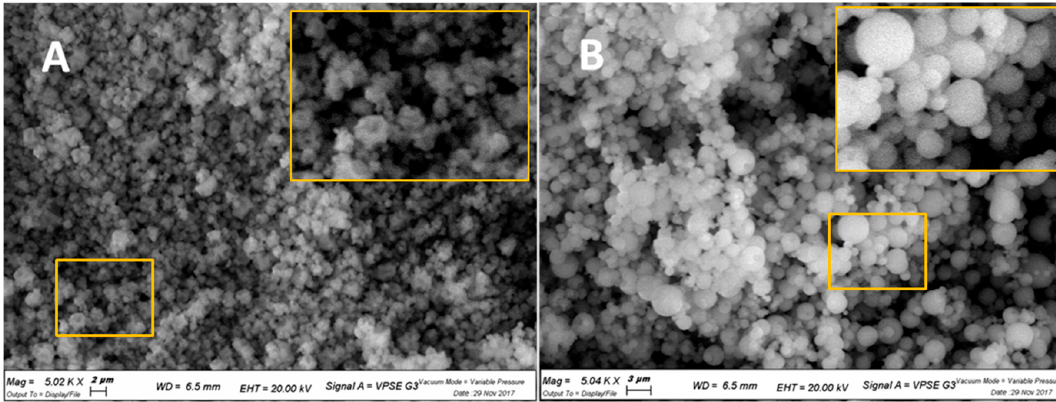
Figure 2. SEM micrographs with magnifications of 5000 times of: ( A ) MC100; ( B ) CH100.